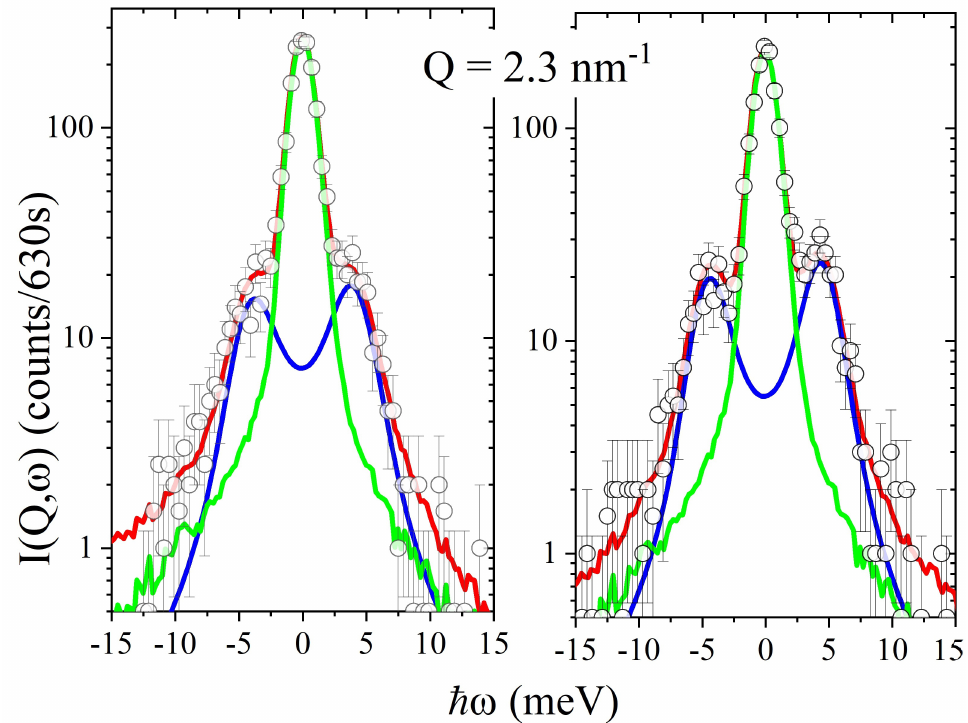
Figure 3. Two IXS spectra measured either in the Au–NP suspension and pure glycerol are reported in the left and right plots, respectively, and therein compared with best fitting model lineshapes (in red) obtained as discussed in the text. The resolution convoluted Damped Harmonic oscillator (blue line) and the elastic contribution δ ( E ) (green line) model components are also reported for